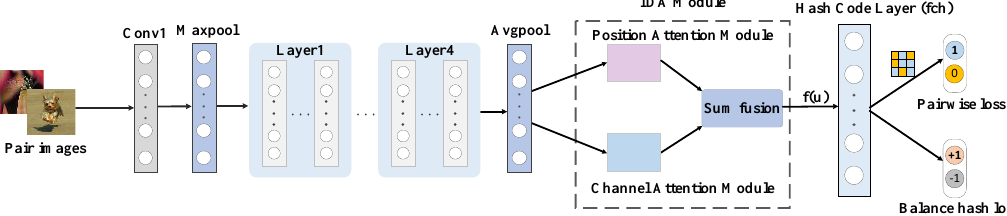
Figure 1. The overall architecture of the deep hash with the improved dual attention module, which is comprised of three key components: (1) pairs of images are fed into the ResNet18 network to obtain deep feature representations; (2) deep features are fed into the IDA module to obtain fusion features; (3) a hash code layer (fch) is used for transforming the fusion feature into K-dimensional binary code.